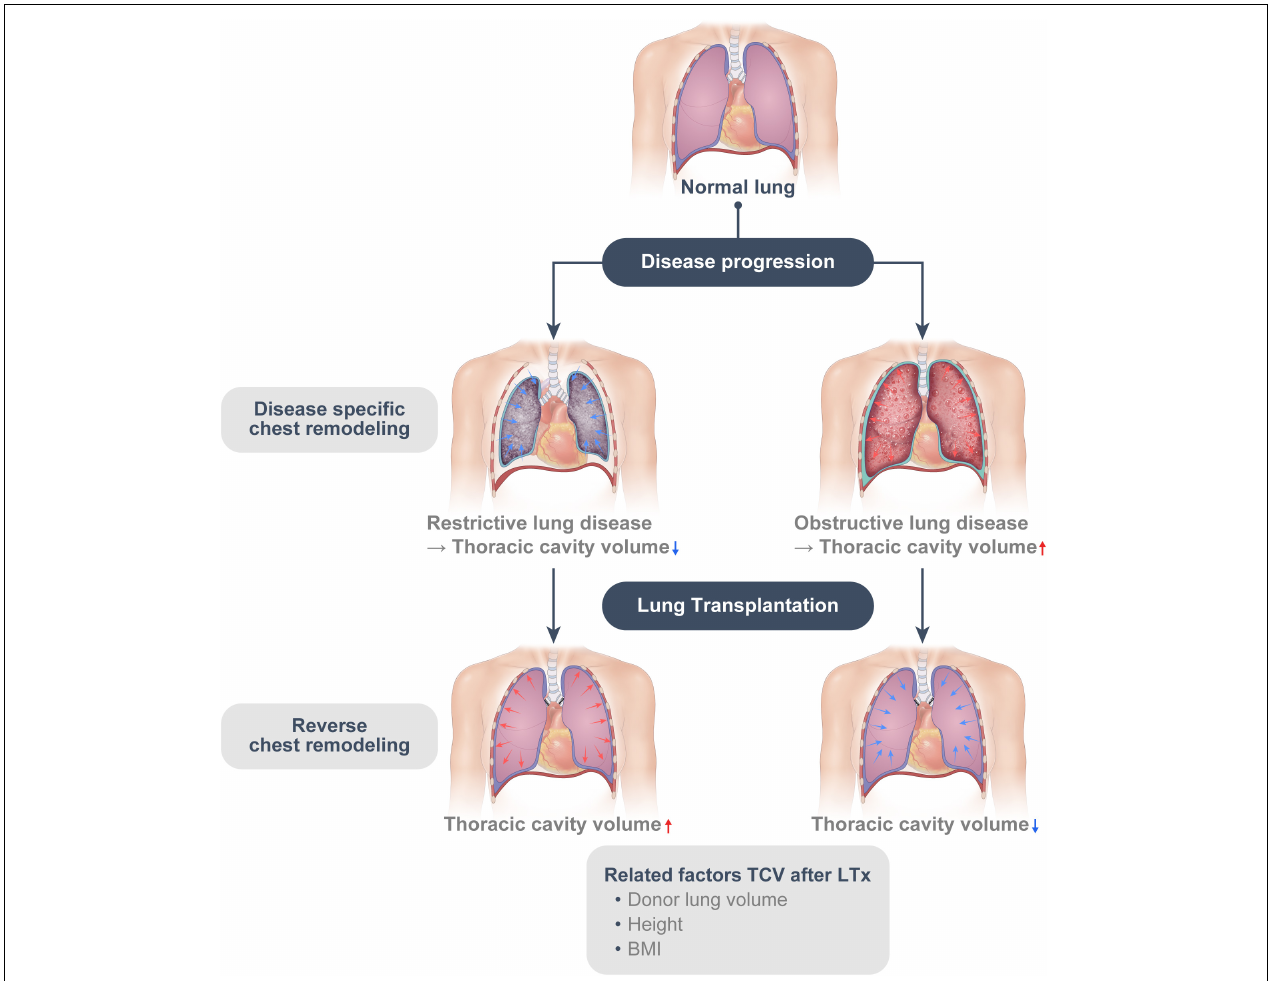
FIGURE 5 | The disease-specific chest remodeling caused by restriction and hyperinflation is at least, in part, reversible. (Reverse chest remodeling).